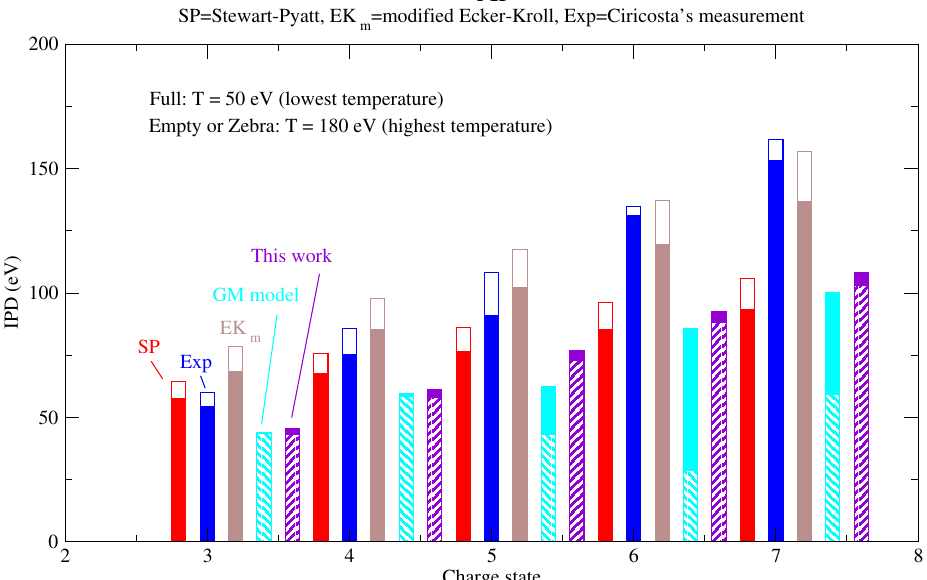
Figure 12. IPD of the different charge states for an aluminum plasma in conditions compatible with Ciricosta’s experiment [30] with different models (red: SP, blue: experimental values, brown: modified EK, brown, cyan: GM model, purple: this work). Histograms: full = lowest temperature T = 50 eV, empty (or zebra): highest temperature T = 180